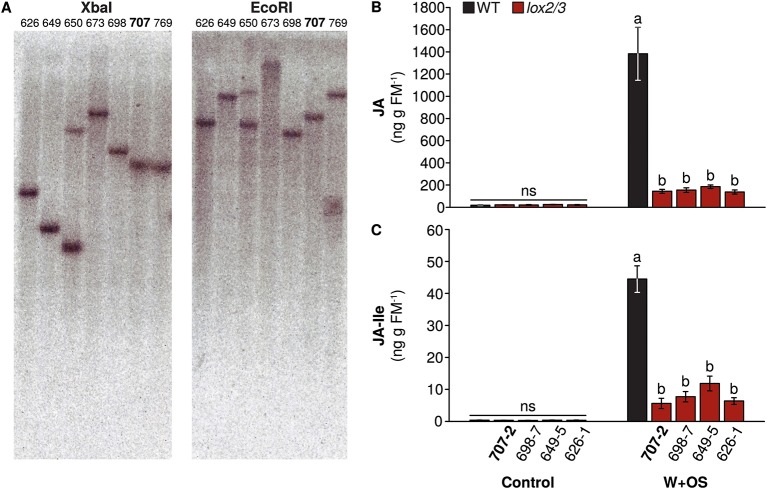
Transgene insertions and reduced jasmonate accumulation in lines of lox2/3.(A) Southern blot of genomic DNA from multiple lines of lox2/3 digested with the restriction enzymes XbaI or EcoRI. Line 707 is highlighted: this line was used for experiments. A single transgene insertion in TPS10 (line 10–3) is shown in Schuman et al. (2014). All lines of lox2/3 screened had strong reductions in their induced (B) JA and (C) JA-Ile accumulation (mean ± SEM, n = 6). Line 707-2 was used for further experiments. a,b Different letters indicate significant differences (corrected p<0.0001) in Tukey HSD tests following significant (p<0.0001) 1-way ANOVAs on natural log-transformed data (JA: F4,25 = 54.15; JA-Ile: F4,25 = 18.00); ns, not significant in 1-way ANOVAs (p>0.4).